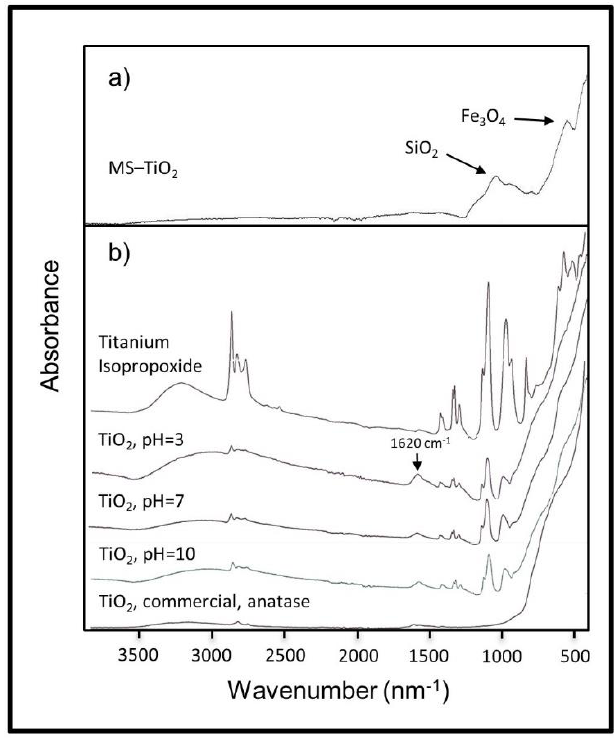
Figure 4. The FTIR spectra of ( a ) as-synthesized MS–TiO 2 and ( b ) the TiO 2 control samples prepared under varied pH conditions without the presence of MS, along with the TIPP precursor and the commercial TiO 2 (anatase) sample.